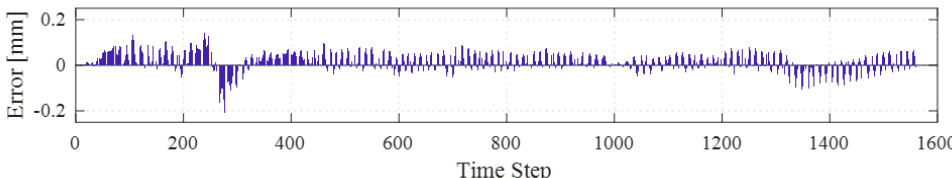
Figure 26. Difference between the exact displacement and prediction calculated at each time step for Model 1a with specimen.